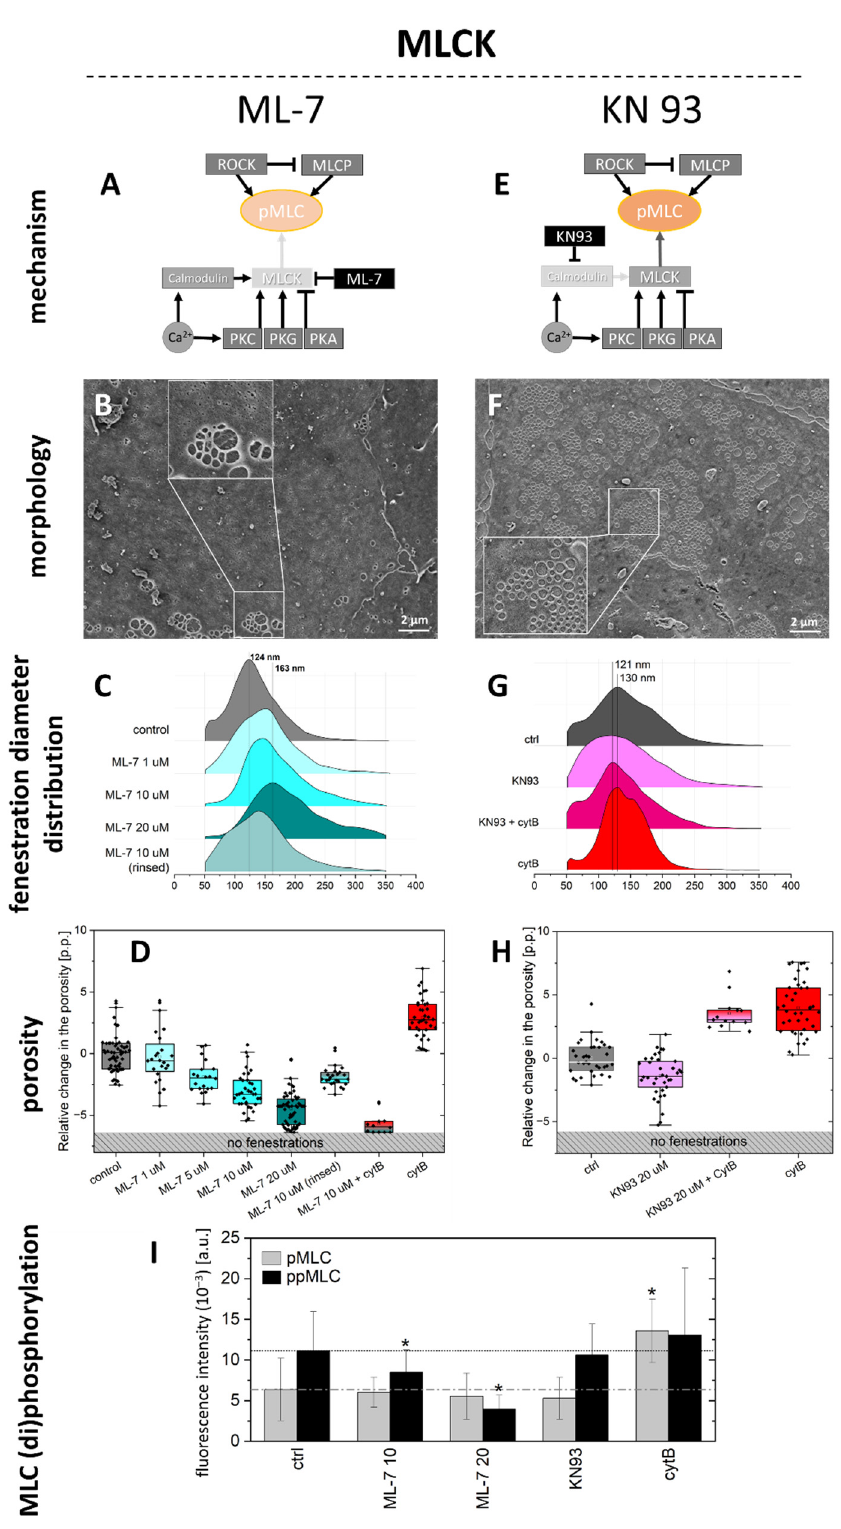
Figure 4. The effect of direct MLCK inhibition and calcium/calmodulin-dependent MLCK inhibition on LSEC fenestrations. ( A ) A schematic presentation of the ML-7 effect. MLC is partially dephosphorylated (faded-red colour) by direct MLCK inhibition. Phosphorylation by Rho/ROCK pathway still occurs. ( B ) A representative SEM image of LSEC treated with 20 µM of ML-7. The inset highlights a small sieve plate with enlarged fenestrations. ( C ) Fenestration diameter distribution (fenestrations measured: ctrl-22618, 1 µM ML-7-8283, 5 µM ML-7-12560, 10 µM ML-7-4630, 20 µM